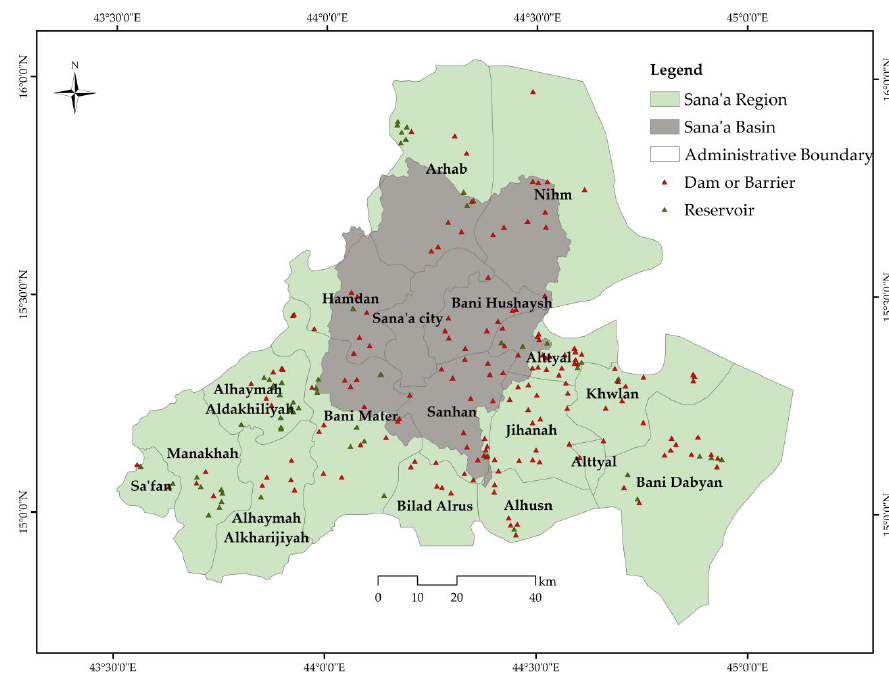
Figure 6. Dams and reservoirs distribution in the study area with Sana’a basin